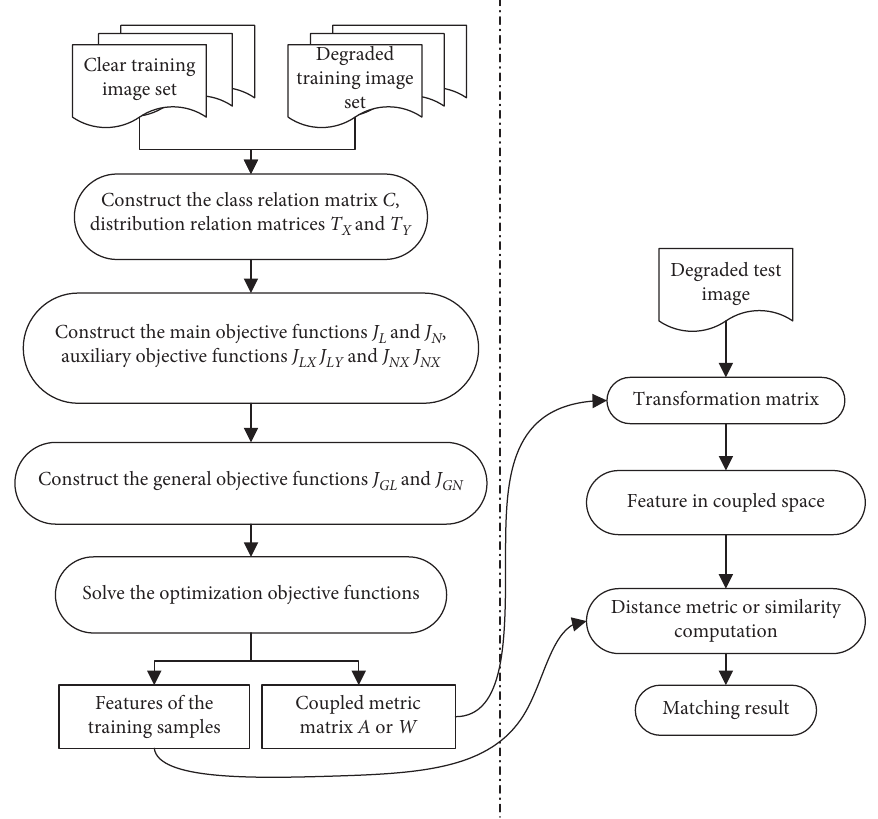
Figure 2: Basic steps of the proposed coupled metric learning. Table 1: Introduction to three face